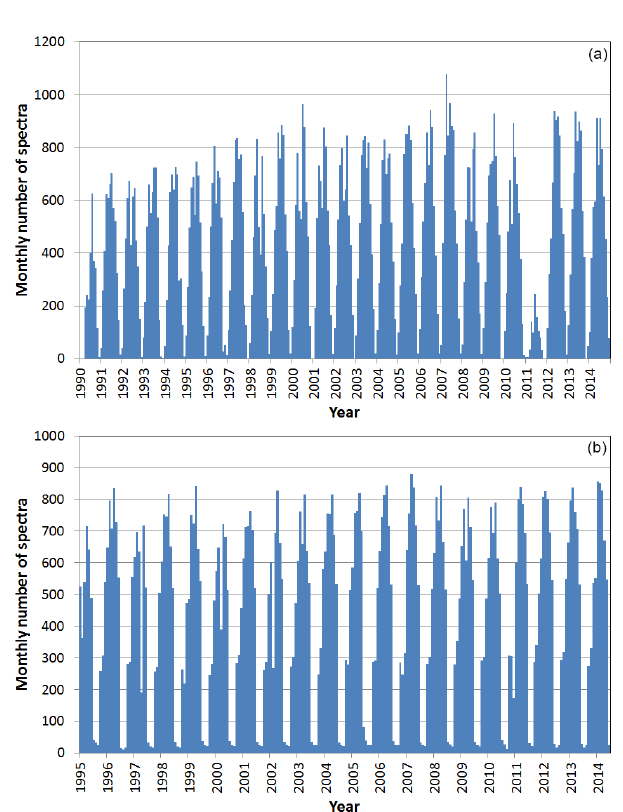
Figure 8. (a) Number of monthly UV irradiance spectra submitted to the EUVDB measured by the Brewer no. 037 during 1990–2014. (b) Number of monthly UV irradiance spectra submitted to the EU- VDB measured by the Brewer no. 107 during 1995–2014.